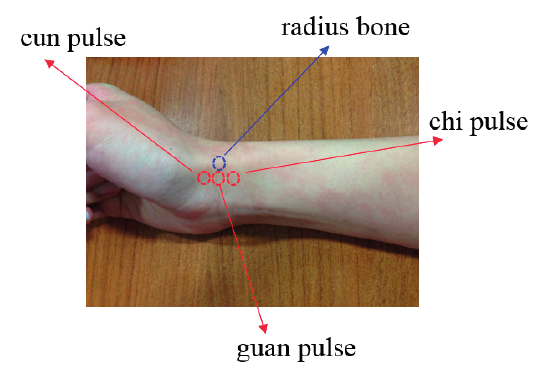
Figure 1. Cun, guan and chi pulse